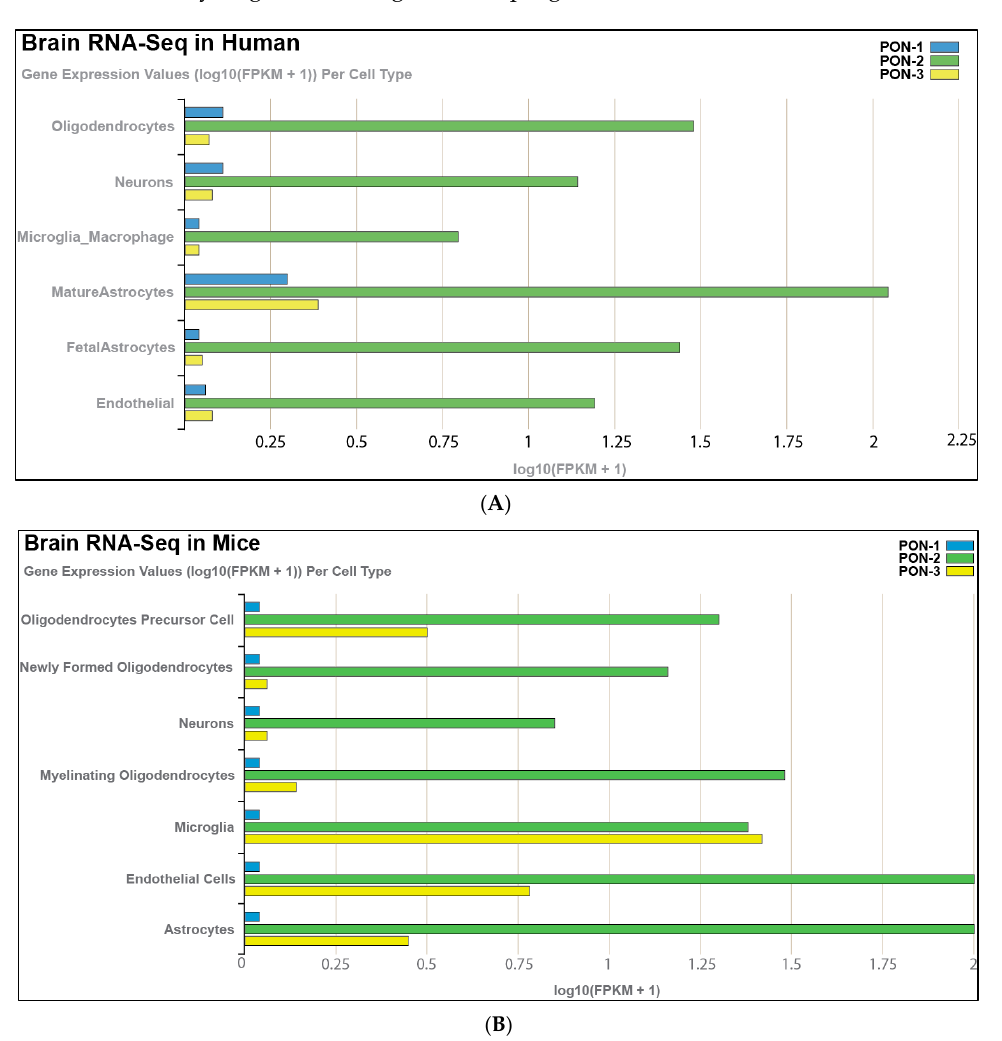
Figure 1. RNA-seq of cells isolated and puri fi ed from gray ma tt er of cortex tissue, highlighting the expression of PON enzymes in di ff erent cell types in ( A ) the human brain and ( B ) the mouse brain. h tt ps://cdrl.shinyapps.io/Kaleidoscope (accessed on 19 July 2021) was used to generate fi gures. Cells were isolated and puri fi ed from the gray ma tt er of cortex tissue of mouse and human brains. Cell- type-speci fi c antibodies were used for puri fi cation: anti-CD45 to capture microglia/macrophages; anti-GalC hybridoma supernatant to harvest oligodendrocytes; anti-O4 hybridoma to harvest OPCs; anti-Thy1 (CD90) to harvest neurons; anti-HepaCAM to harvest astrocytes; and BSL-1 to harvest endothelial cells . 2. Overview of PON-1 and Its Neurological Associations Neurodegenerative diseases (ND) are a broad range of disorders characterized by neuronal tissue damage and loss of function, leading to cell death [20]. The etiology of ND is multifactorial and still not fully understood [21]. However, many of these disorders seem to have common cellular and molecular mechanisms underlying the pathogenesis; for example, certain toxin exposures, increased oxidative stress, and decreased antioxi- dant activity [22]. PON enzymes serve as an important physiological redox system which participates in protecting against cellular injury caused by genotoxic and oxidative dam- age. PON-1 is a hydrolytic lactonase enzyme that is synthesized in the liver and circulates bound to HDL. It provides the antioxidant property that prevents LDL and HDL oxida- tion and contributes to much of the anti-oxidative and anti-atherogenic activities that have been a tt ributed to HDL [23,24]. It also protects HDL and LDL from oxidative stress through the elimination of ROS produced by metabolism. PON possesses peroxidase-like activity that can contribute signi fi cantly to the protective e ff ect of PON against lipoprotein oxidation [25]. PON enzyme activity in serum has been correlated with protection against oxidative damage [26,27]. Oxidative stress plays an essential role in the pathogenesis of many ND, even though the exact mechanistic links are not fully elucidated. Nevertheless, many studies have highlighted the links between PON-1 and ND progression [28–30]. PON-1 protects against atherogenesis by metabolizing oxidized lipids. Its essential role as a protective factor against atherogenesis continues to a tt ract more a tt ention in epi- demiological studies [31,32]. Studies have demonstrated PON-1’s role in ischemic stroke, one of the top neurological disorders linked with atherosclerosis [33–37]. Beyond stroke, pesticide exposure has consistently been associated with the development of ND [38,39]. Exposure to pesticides results in induced oxidative stress, mitochondrial dysfunction, and impairment of the ubiquitin–proteasome system, mechanisms that are related to neuronal cell death in ND [40]. PON-1 detoxi fi es xenobiotics, including pesticides, and also